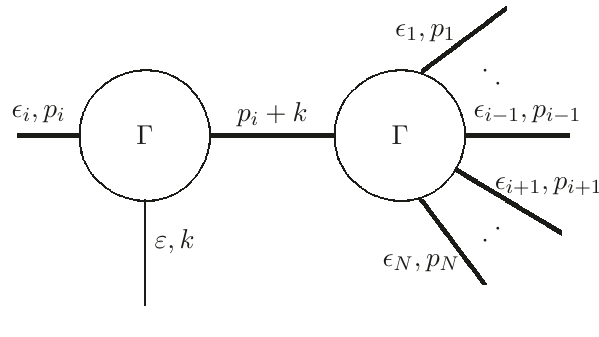
Figure 1 . Source of the leading contribution to the string loop amplitude with one external soft graviton. ǫ i and p i denote the polarization and momentum of the i -th external finite energy particles, while ε µν and k denote the polarization and momentum of the external soft